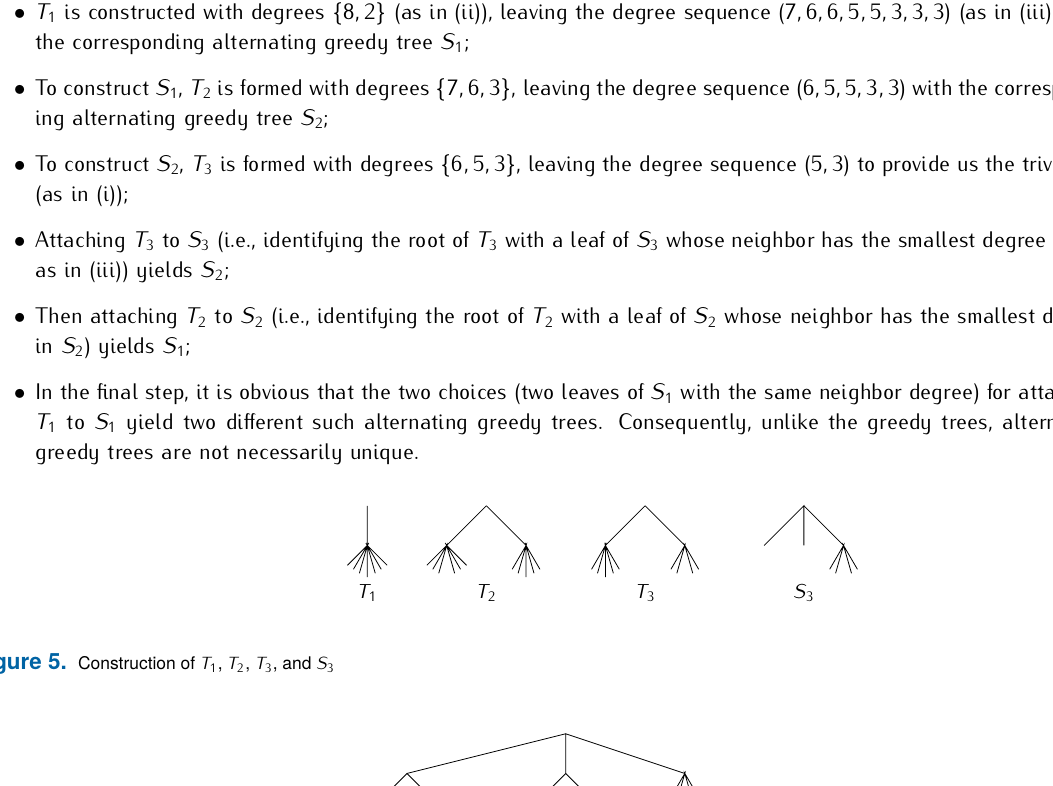
Figure 5. Construction of